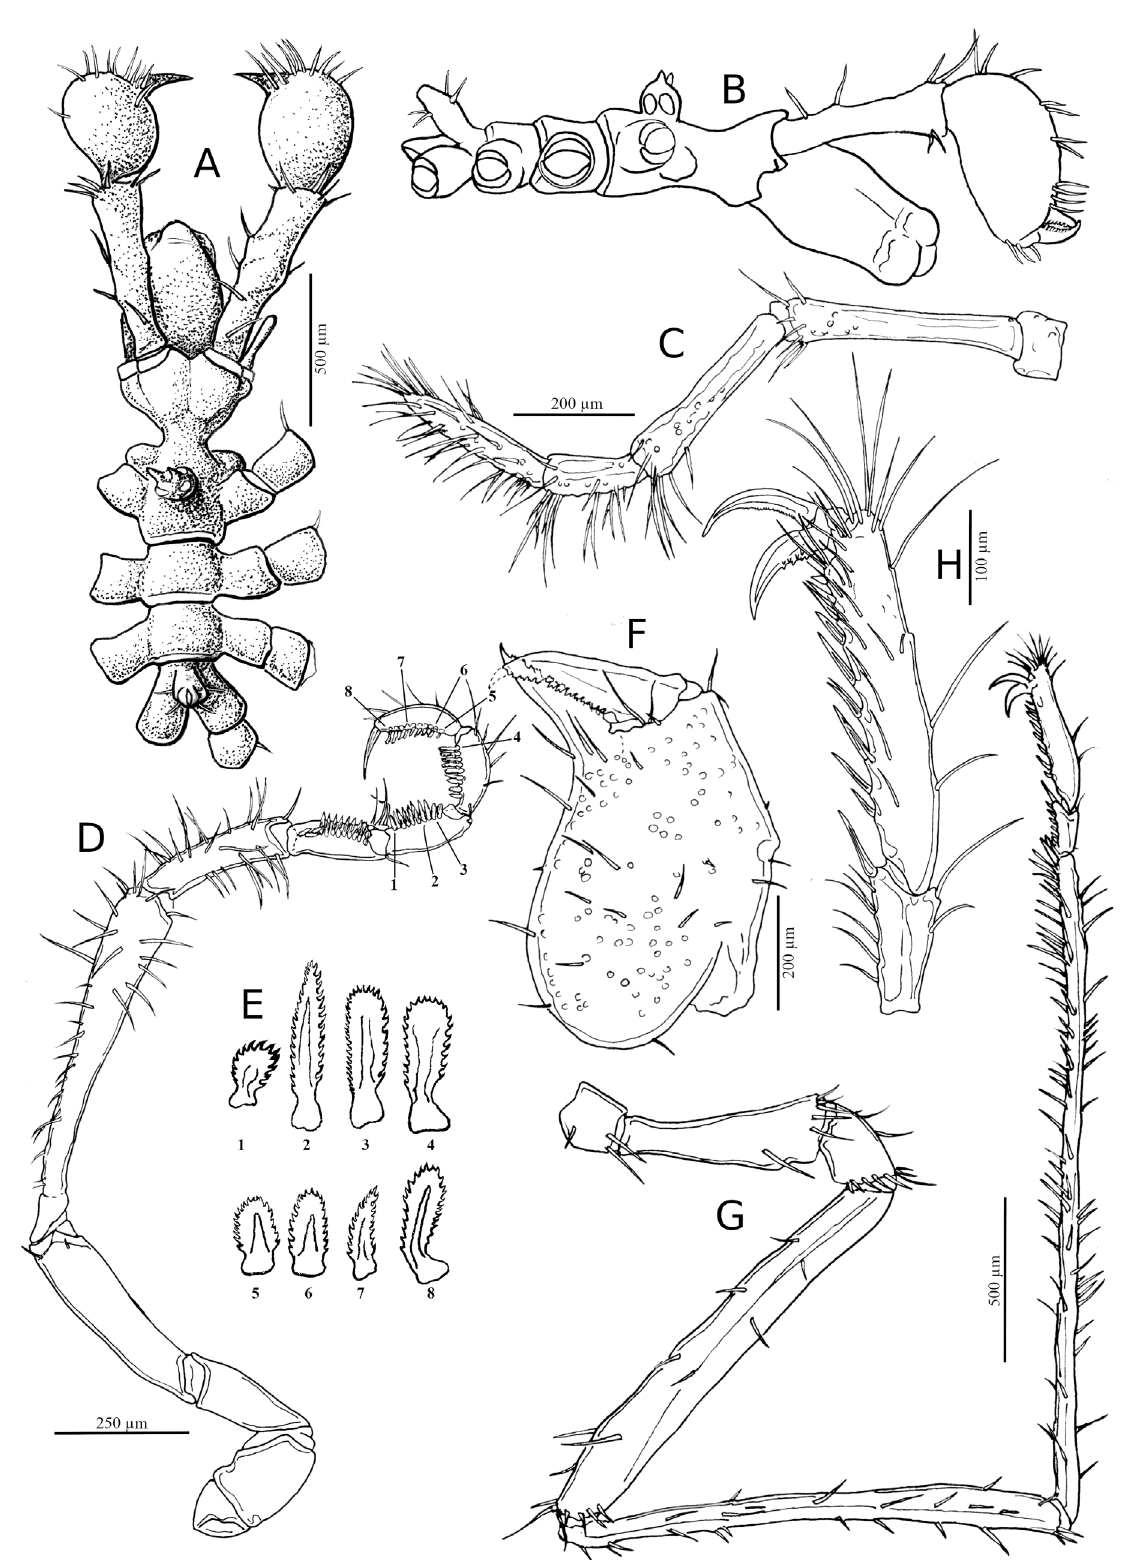
Fig. 11. Nymphon dorlis sp. nov., holotype, ♂, MNHN-IU-2016-879. A . Body, dorsal view. B . Body, lateral view (same scale as A). C . Palp. D . Oviger. E . Pointed teeth of oviger. F . Chela. G . Third leg. H . Tarsus and propodus of third